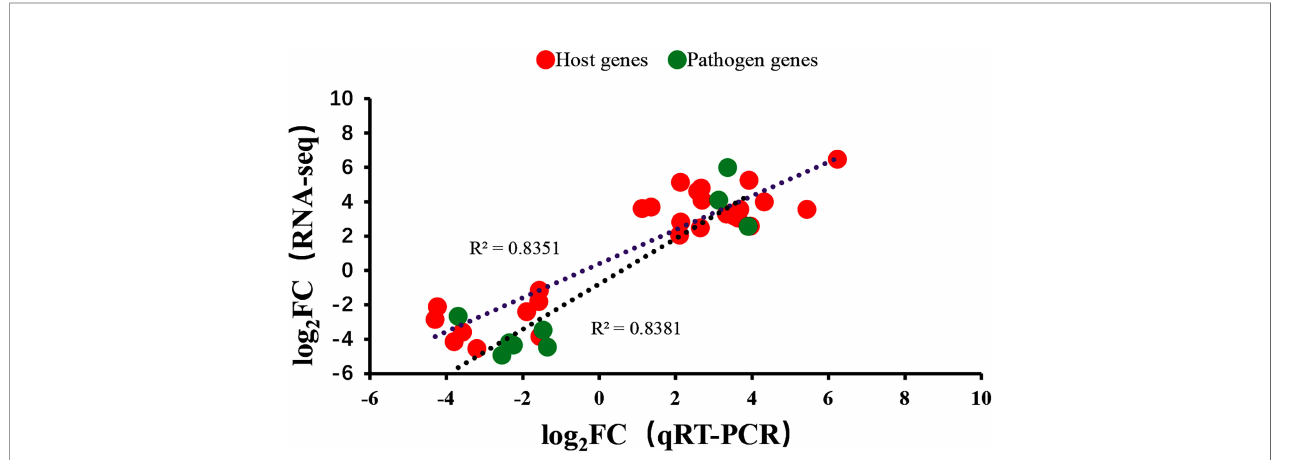
FIGURE 8 | Comparison of gene expression levels for 12 genes using dual RNA-Seq and qRT-PCR. Negative values indicated that the gene expression in channel cat fi sh was downregulated after infection by Y. ruckeri and positive values indicated an upregulation in gene expression after infection.